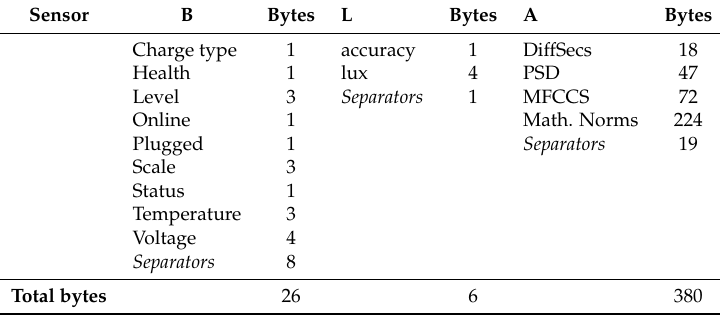
Table 5. Bytes stored per reading for each type of